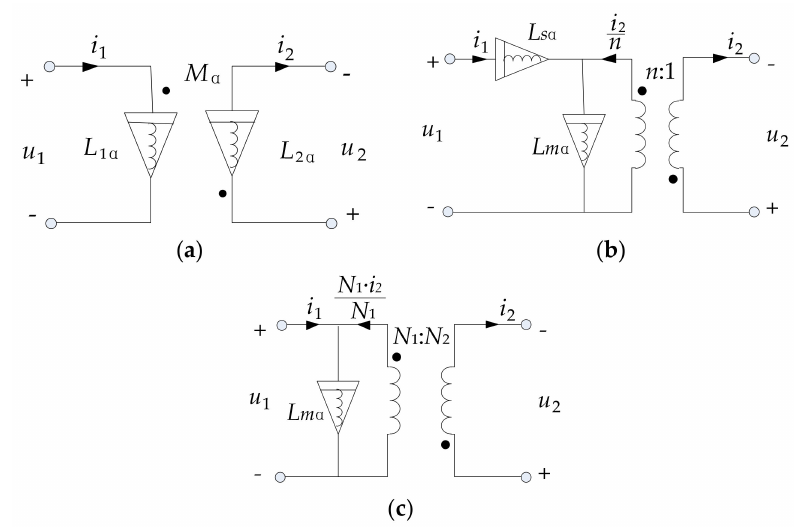
Figure 1. ( a ) The fractional-order mutual inductance model. ( b ) The equivalent circuit of the fractional-order mutual inductance model when the leakage inductance is considered. ( c ) The equivalent circuit of the fractional-order mutual inductance under the fully coupled